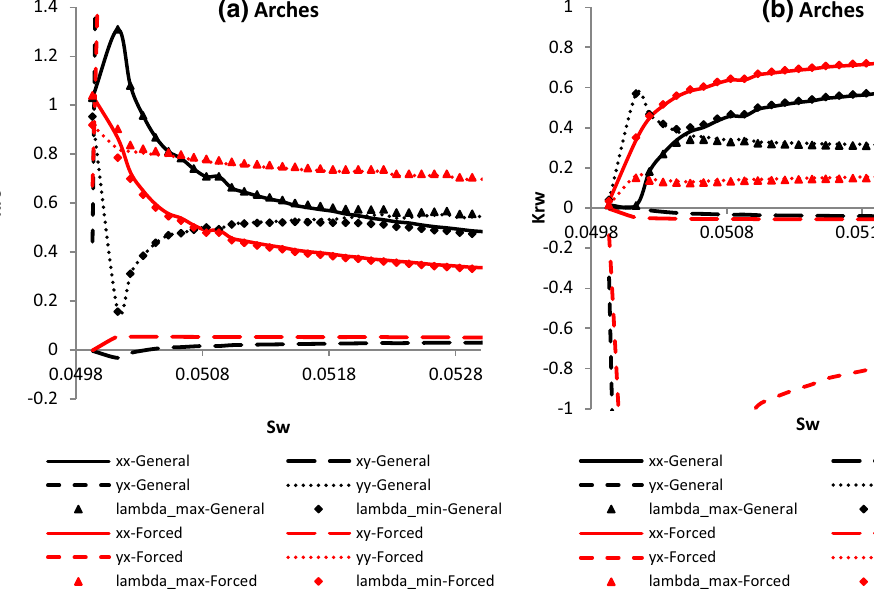
Fig. 6 Relative permeability tensor components for oil ( a ) and water ( b )